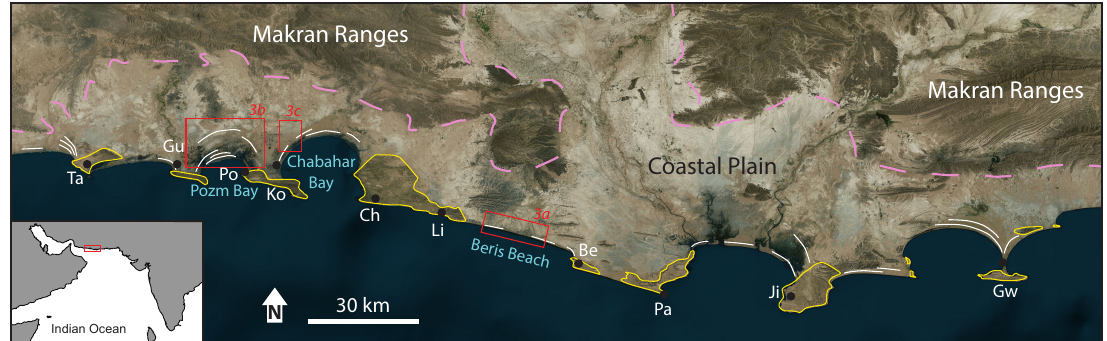
Figure 1. General satellite view of a segment of the Makran coast (image Bing satellite). Pink dashed line: rough delineation of the Makran ranges. White lines: beach ridges. Yellow outlines: protruding headlands. Blue names: studied regions. Red squares: locations of Figure 3a–c. Ta: Tang, Gu: Gurdim, Po: Pozm, Ko: Konarak, Ch: Chabahar, Li: Lipar, Be: Beris, Pa: Pasabander, Ji: Jiwani, Gw: